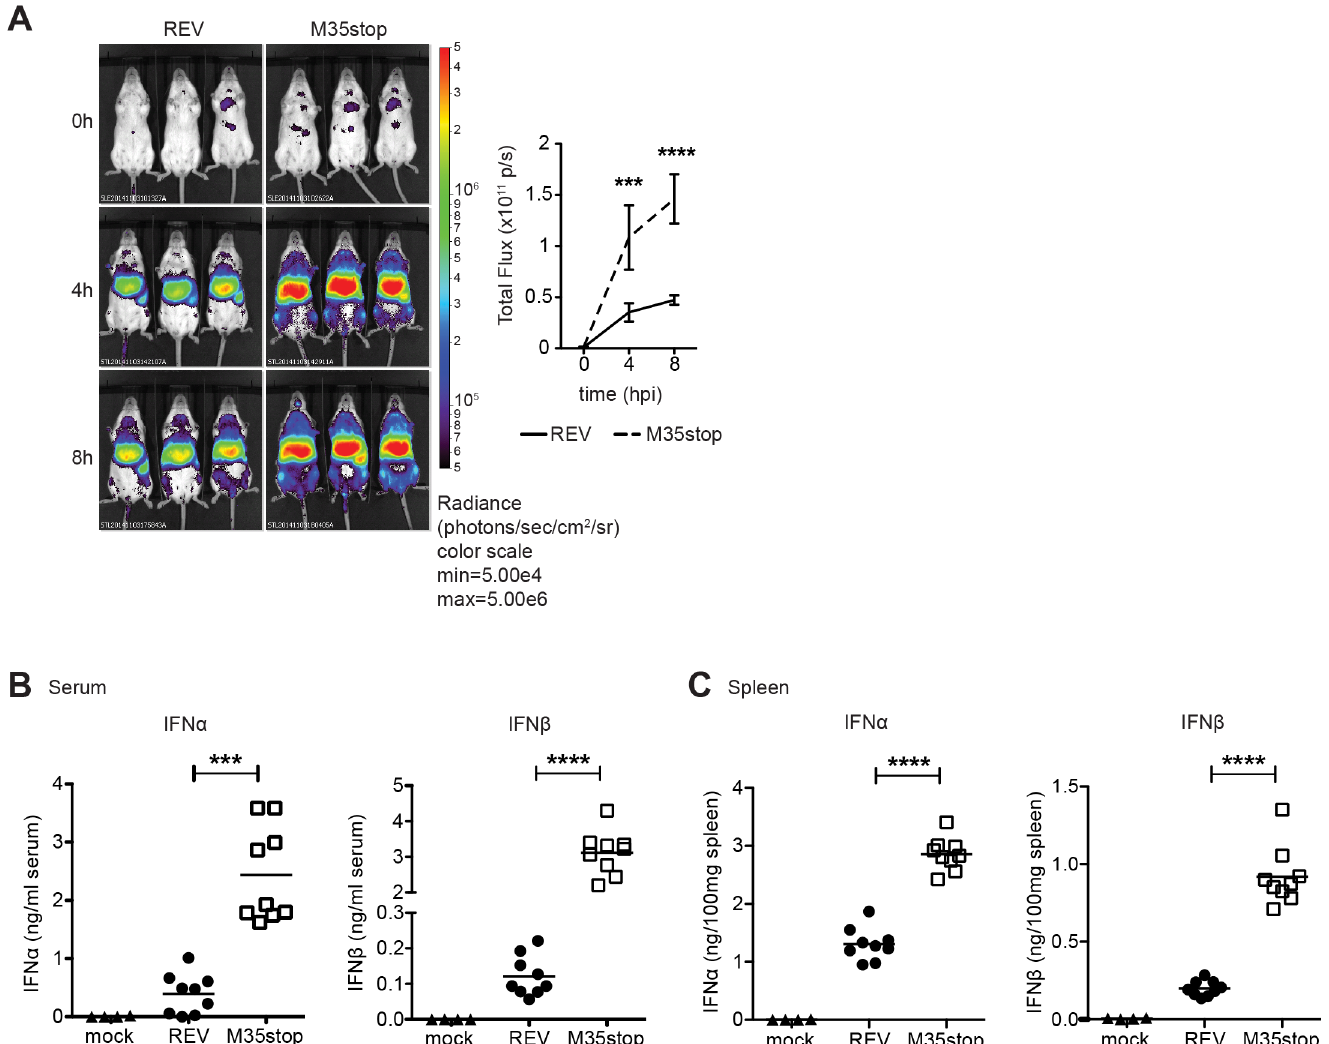
Fig 9. M35 inhibits the induction of type I IFN in vivo . (A) In vivo whole-bodyimagingof luciferaseactivity in IFN- β +/ Δβ -luc BALB/c reporter mice upon i.v. infection with 2 x 10 5 PFU MCMV-M35stop-REV(REV) or MCMV-M35stop (M35stop) (left panel). Imagingwas performed at 0, 4 and 8 hours p.i. after i.v. injectionof the luciferase substrate luciferin.Right panel shows correspondingquantification of luciferase activity by regionof interest analysisof the liver. Data is shown as mean ± SD and representative of two independent experiments. Type I IFN levels in serum (B) and spleen (C) followingi.v. infectionwith 4 x 10 5 PFU MCMV-M35stop-REV (REV) or MCMV-M35stop (M35stop) of BALB/c mice at 6 hours p.i. The levels of IFN α (respectiveleft panel)and IFN β (respective right panel)in the serum and spleen organ homogenates were quantifiedby ELISA. Mock denotesuninfectedmice. Data shown is combinedfrom two independentexperiments. *** p < 0.001 and **** p < 0.0001.